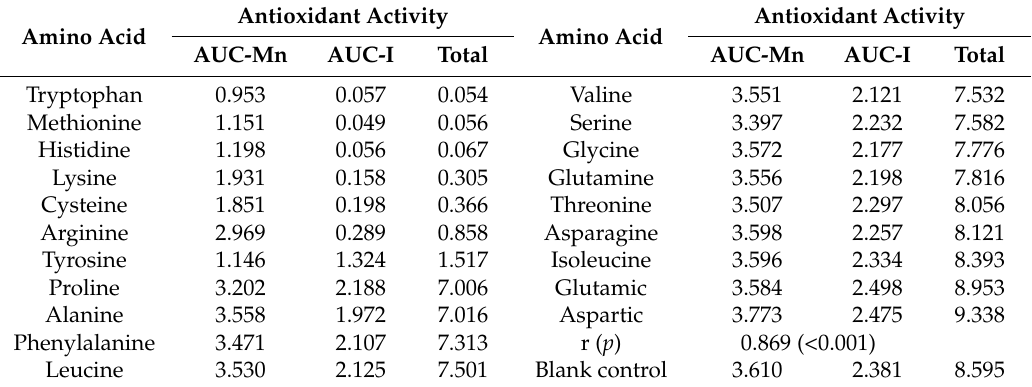
Table 2. Comparison of the antioxidant activity of amino acids based on experimental results. Antioxidant Amino Acid